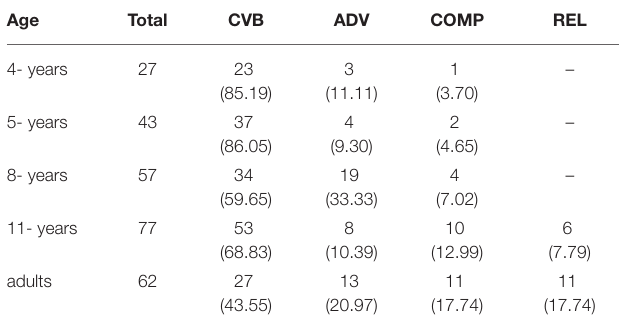
TABLE 4 | Frequency (percentage) of types of non-finite clauses in 1-NCL complex sentences by